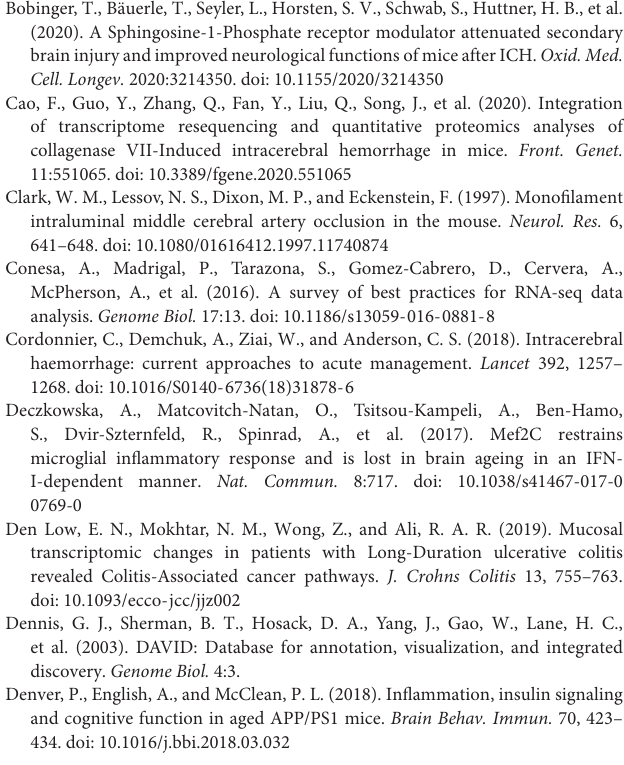
Supplementary Figure 1 | (A) The mRNA expression levels of stimulator of interferon genes (STING), (B) TANK binding kinase (TBK1), (C) interferon regulatory factor 3 (IRF3) and (D) interferon- α (IFN- α ) were measured by real-time quantitative polymerase chain reaction (RT-qPCR). The mRNA expression is reported as the FC vs. young mice after sham surgery. The data are shown as the mean 2 − (cid:49)(cid:49) CT value ± SEM; young sham: n = 5; young ICH: n = 4; aged sham: n = 4; aged ICH: n = 4; ns means P > 0.05. Supplementary Figure 2 | Protein-protein interaction network analysis for differentially expressed genes (DEGs) of (A) “more upregulated in the aged intracerebral hemorrhage (ICH) group” and (B) “more down regulated in the aged ICH